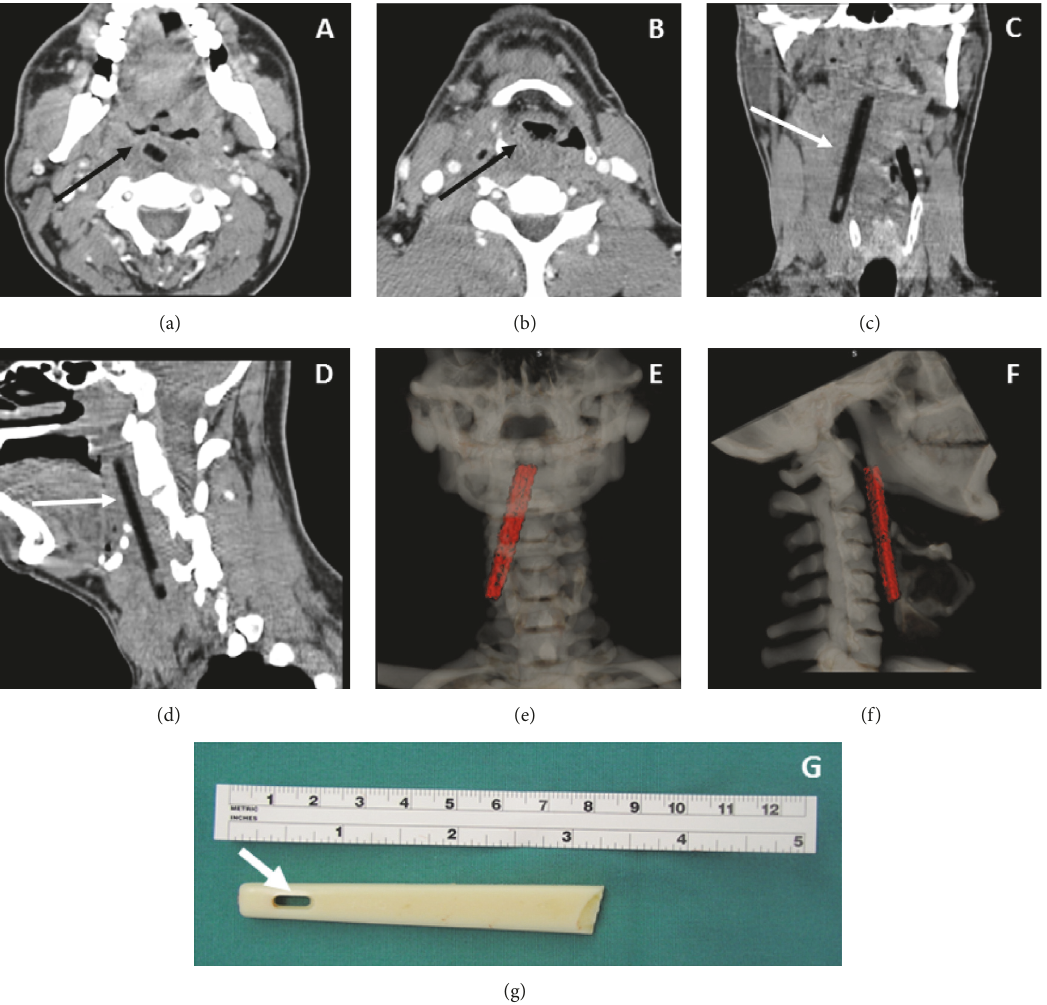
Figure 1: Two-dimensional axial (a, b), coronal (c), and sagittal (d) CT images and 3-dimensional coronal (e) and sagittal (f) reformats show a low density linear structure on the 2-dimensional images (white arrow) which is outlined in red on the 3-dimensional images. It is imbedded within the retropharyngeal soft tissues and extends from the level of the oropharynx through the hypopharynx to the right lateral extrapharyngeal soft tissues (black arrow). There is a linear gap at the end of the foreign body which represents the opening within the toothbrush handle (arrow